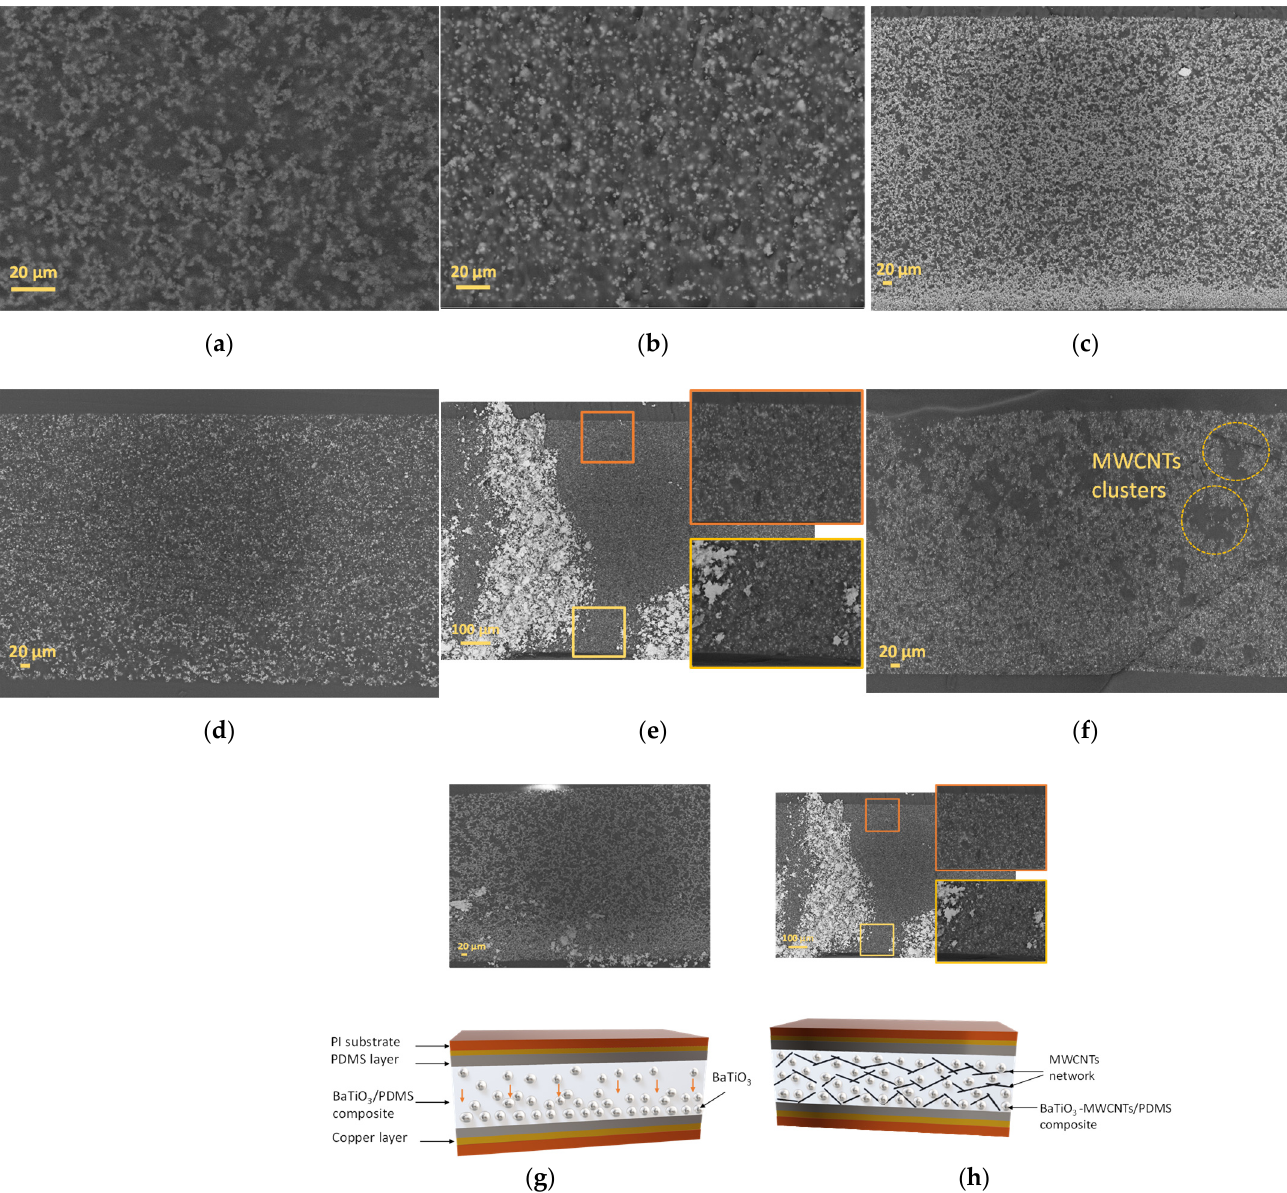
Figure 3. SEM images done in the cross-section for different composites and showing the effects of the addition of MWCNTs: ( a – c ) composites with 15 wt.% BaTiO 3 , 20 wt.% BaTiO 3 , and 40 wt.% BaTiO 3 , respectively; ( d – f ) 15 wt.% BaTiO 3 /PDMS composite containing 0.3 wt.% MWCNTs, 0.5 wt.% MWCNTs, and 0.75 wt.% MWCNTs, respectively; and ( g , h ) illustration of the distribution of BaTiO 3 in two different cases without and with MWCNTs, respectively.